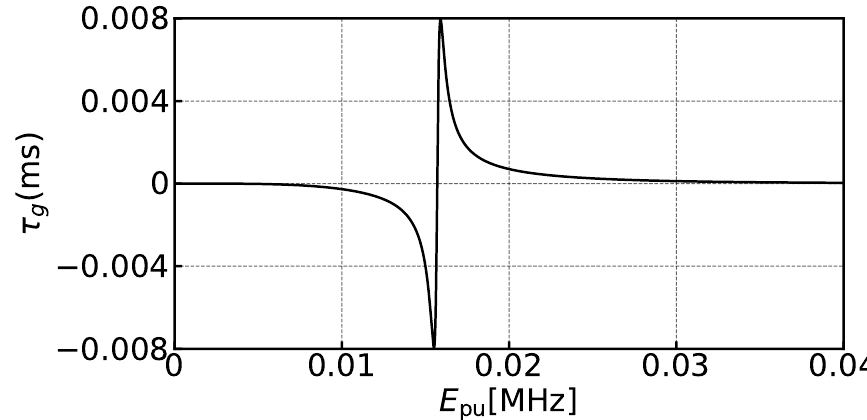
Figure 4. Group delay τ g (in ms) as a function of E pu . The other parameters are the same as in Figure